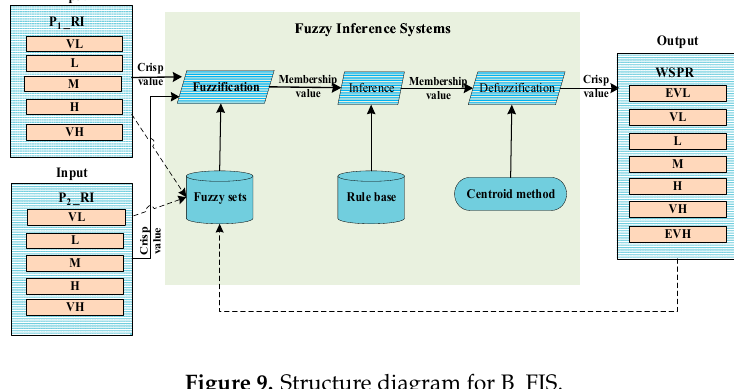
Figure 9. Structure diagram for B_FIS. Table 3. Fuzzy rules in the blended FIS.